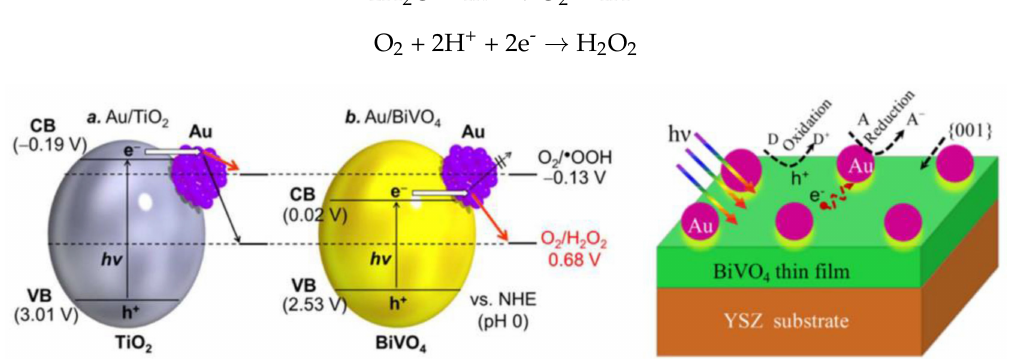
Figure 16. The mechanism of H 2 O 2 generation ( left ) (Reprinted with permission from Reference [167] Copyright (2016) published by American Chemical Society) and the enhanced electron transfer mechanism, when shape-tailored BiVO 4 was applied ( right ) (Reproduced with permission from Reference [168] published by Elsevier).